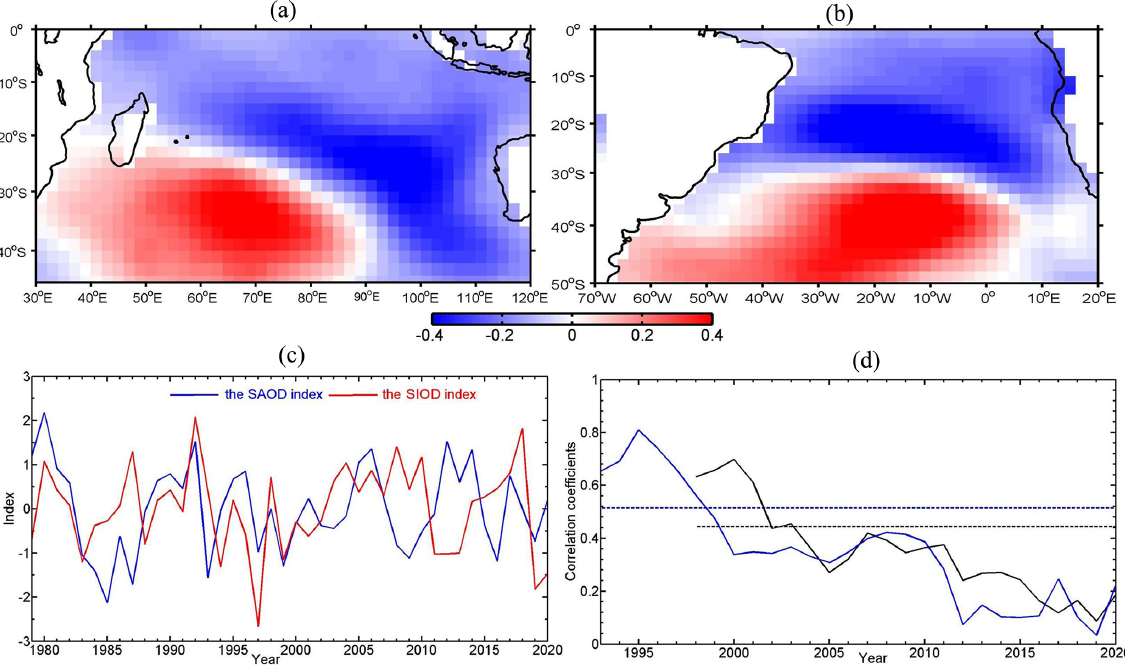
Figure 1. Regression patterns of austral summer (JFM) SST anomalies ( ◦ C) on the positive phases of the summertime indices of (a) the Subtropical Indian Ocean Dipole (SIOD) and (b) the South Atlantic Ocean Dipole (SAOD), (c) their time coefficients, and (d) the moving correlations between the detrended and ENSO-signal-removed SIOD and SAOD indices (time coefficients) using a 20-year (solid black line) and a 15-year (solid blue line) sliding window. In (d) , the dashed lines denote the correlation coefficients with the 95% confidence level for 20 (black) and 15 (blue) samples, and the abscissa indicates the end year of the moving correlations. The above results were derived using the NOAA Extended Reconstructed SST V5 data.